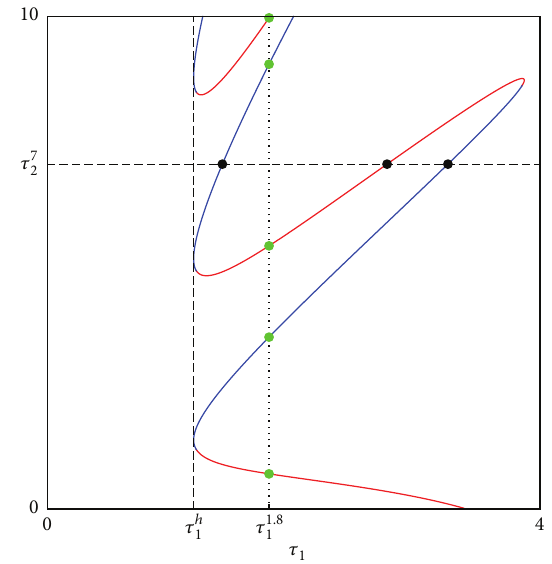
Figure 2: Stability switching